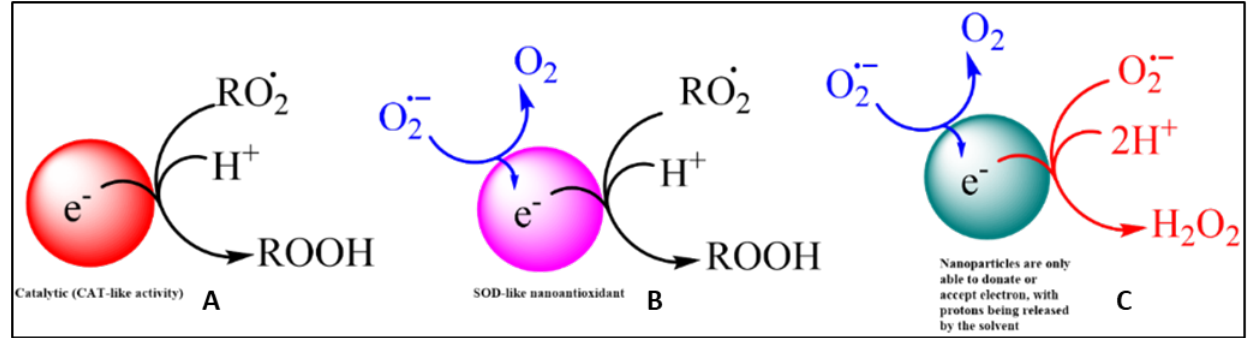
Figure 5. Comparisons and contrasts between sacrificial ( A ), catalytic, and ( B ) SOD-like nanoantioxidants ( C ). Nanoparticles as the electron donor or accepter.